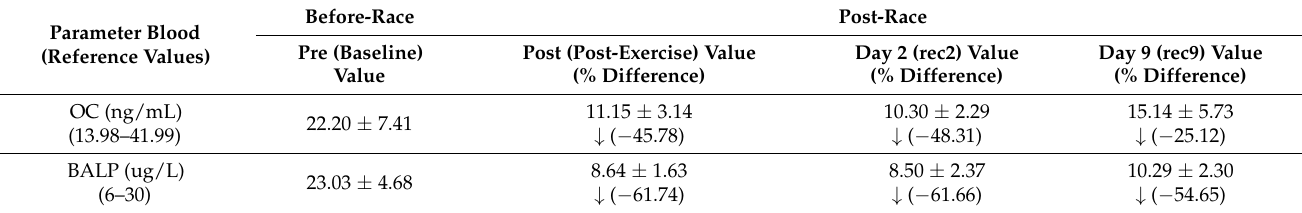
Table 3. Blood parameters before (baseline) and after race (post-exercise day 2 and post-exercise day 9). Parameter Blood (Reference Values)